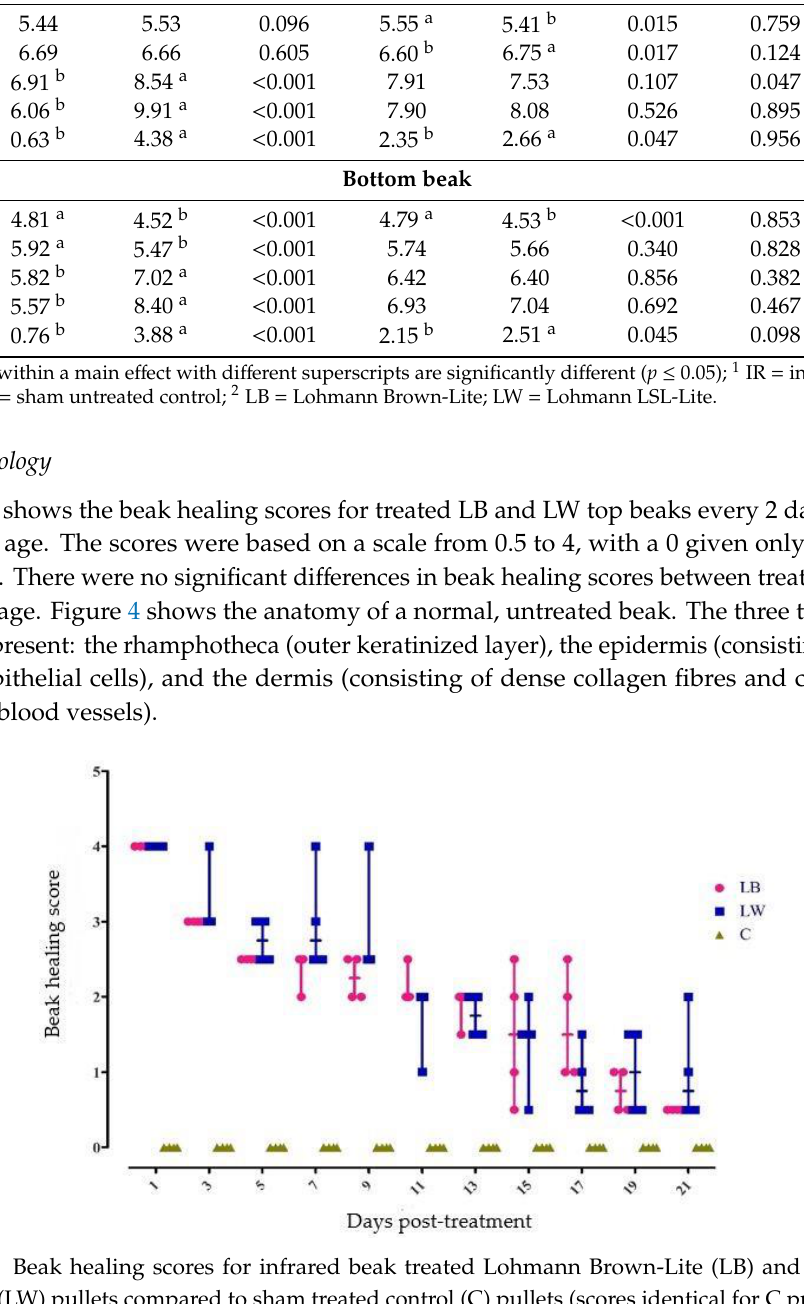
Figure 4. Histological section of the top beak of a C pullet. The three tissue layers of the beak (rhamphotheca, epidermis, and dermis) are indicated. Multiple nerve endings (Herbst corpuscles) and mature collagen bundles are visible within the dermis layer. H&E staining. Magnification 4×.